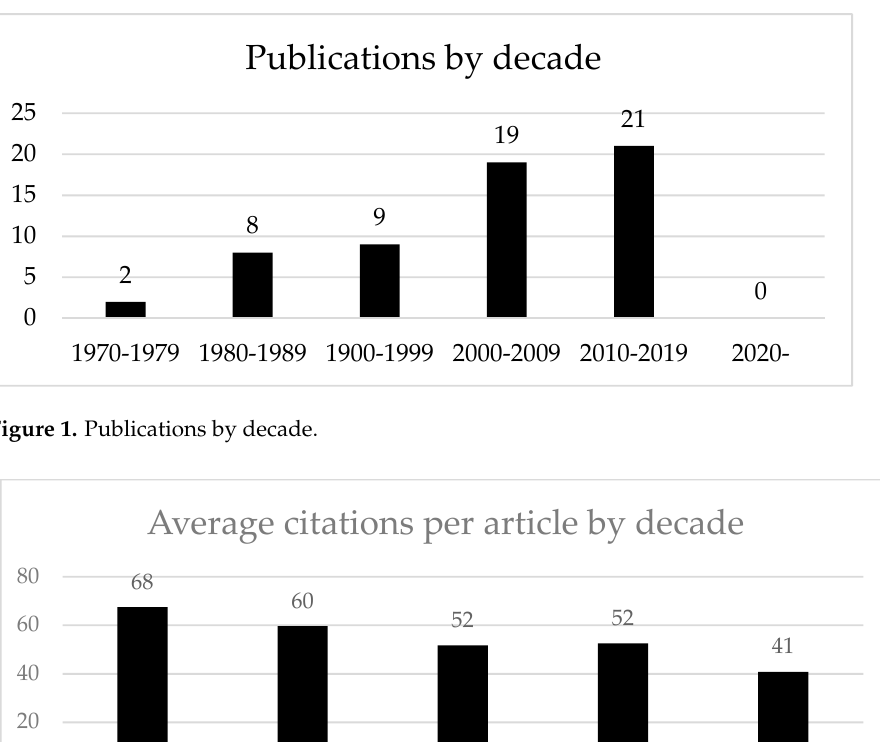
Table 3. Top 8 most productive institutions .